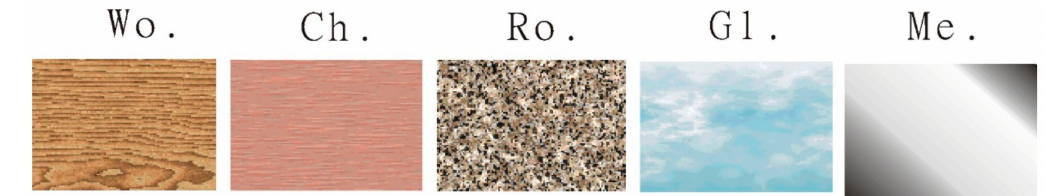
Figure 7. Digital texture